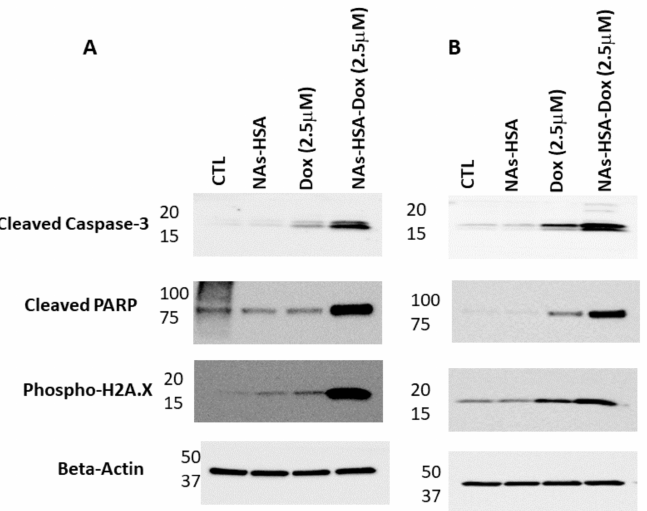
Figure 4. NAs-HSA-Dox enhances apoptotic cell death in DIPG neurospheres; ( A ) HSJD-DIPG007 cells were treated with NAs-HSA-Dox and free Dox at the equivalent dose of 2.5 µ M for 24 h; ( B ) RA055 cells were treated with NAs-HSA-Dox and free Dox at the equivalent dose of 2.5 µ M for 24 h; Representative images of western blots show elevated levels of apoptotic markers cleaved- caspase 3 and cleaved-PARP in the NAs-HSA-Dox-treated cells. Similarly, an increase in Phospho- H2A.X was observed in NAs-HSA-Dox-treated DIPG cells. In contrast no difference was observed among the untreated, NAs-HSA and free Dox treated samples. Western blot analysis was performed twice for each primary DIPG culture (Figure